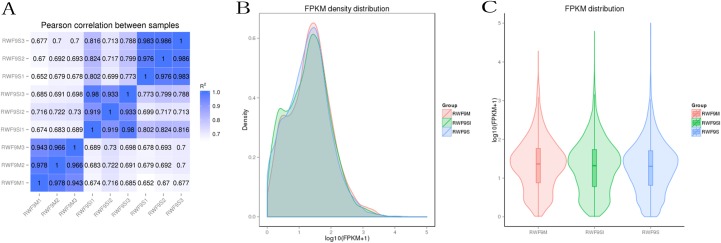
Bioinformatic analyses of RNA-seq data.(A) Pearson correlation between samples. (B) FRKM density distribution. (C) FRKM distribution.